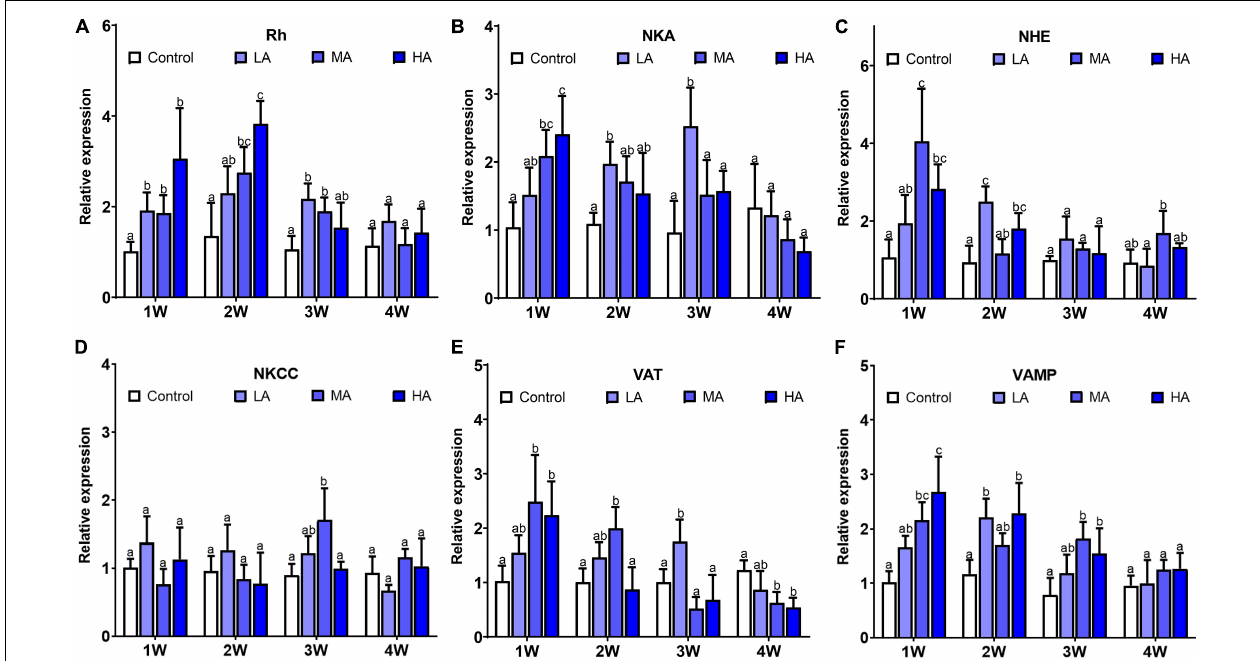
FIGURE 2 | Expression of NKA (A) , Rh (B) , NHE (C) , NKCC (D) , VAT (E) , and VA MP (F) in different treatments during long-term ammonia stress. Values are means ± S.D ( n = 3). Different letters represent significant differences among different groups ( P <